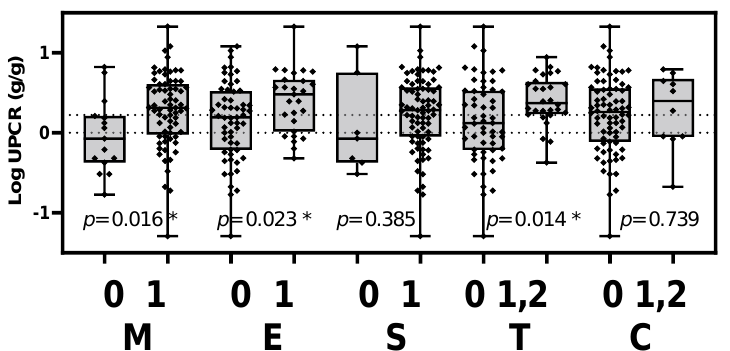
Figure 2. Levels of proteinuria in the Oxford classification MEST-C score-stratified groups. UPCR levels were significantly elevated in IgAN patients with mesangial hypercellularity ( p = 0.016), endocapillary hypercellularity ( p = 0.023) and tubular atrophy/interstitial fibrosis ( p = 0.014). UPCR, urinary protein to creatinine ratio; M, mesangial hypercellularity; E, endocapillary hypercellularity; S, segmental glomerulosclerosis; T, tubular atrophy/interstitial fibrosis; C, cellular or fibrocellular crescents. * p < 0.05.